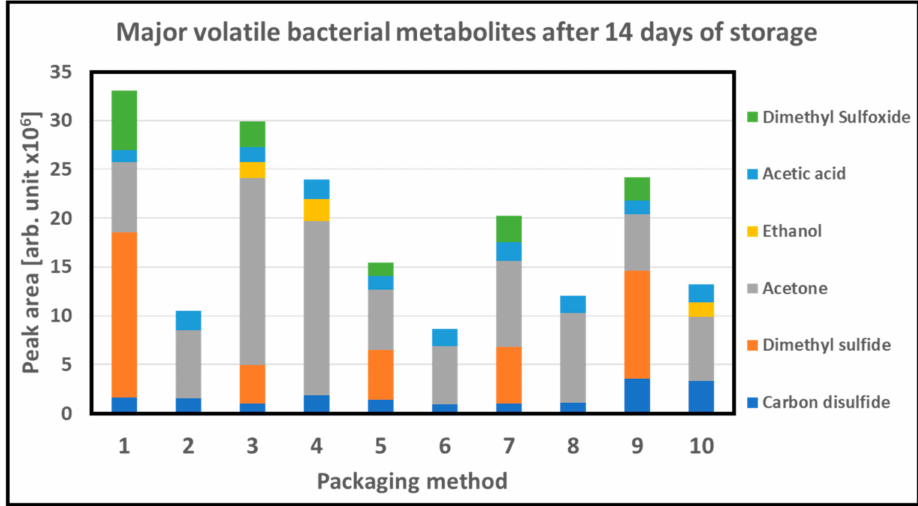
Figure 10. Major volatile bacterial metabolites in the packaging headspace containing chicken fillets packed with different packaging combinations after 14 days of